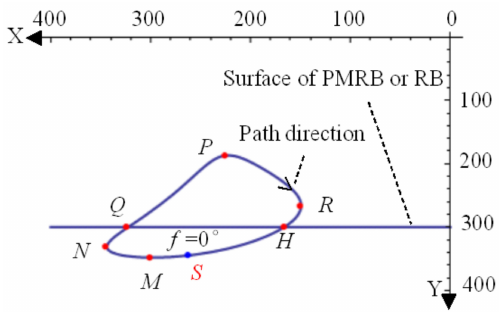
Figure 6. Transplanting track and main parameter points. Note: P , the uppermost point of the planting track; M, the deepest point of the planting track; N, the farthest point of the planting track; R, the nearest point of the planting track; H, the penetrating point; Q, the unearthed